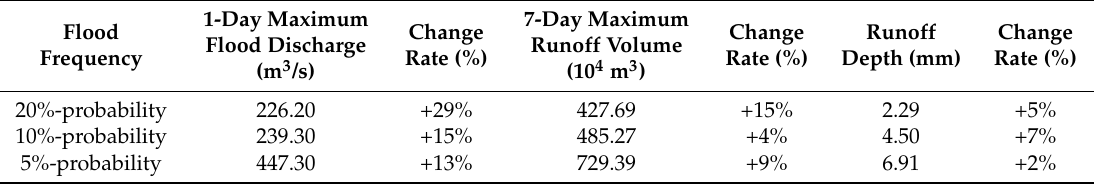
Table 10. The results of three indictors of